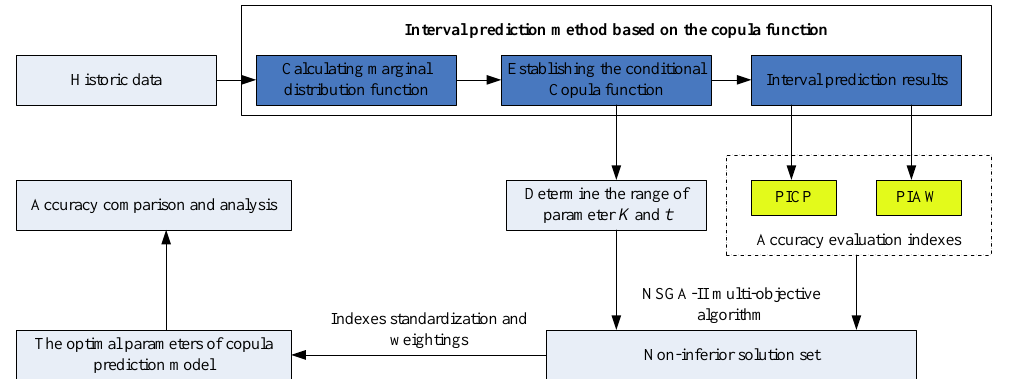
Figure 1. Process diagram of the multi-objective prediction method based on the conditional copula function.